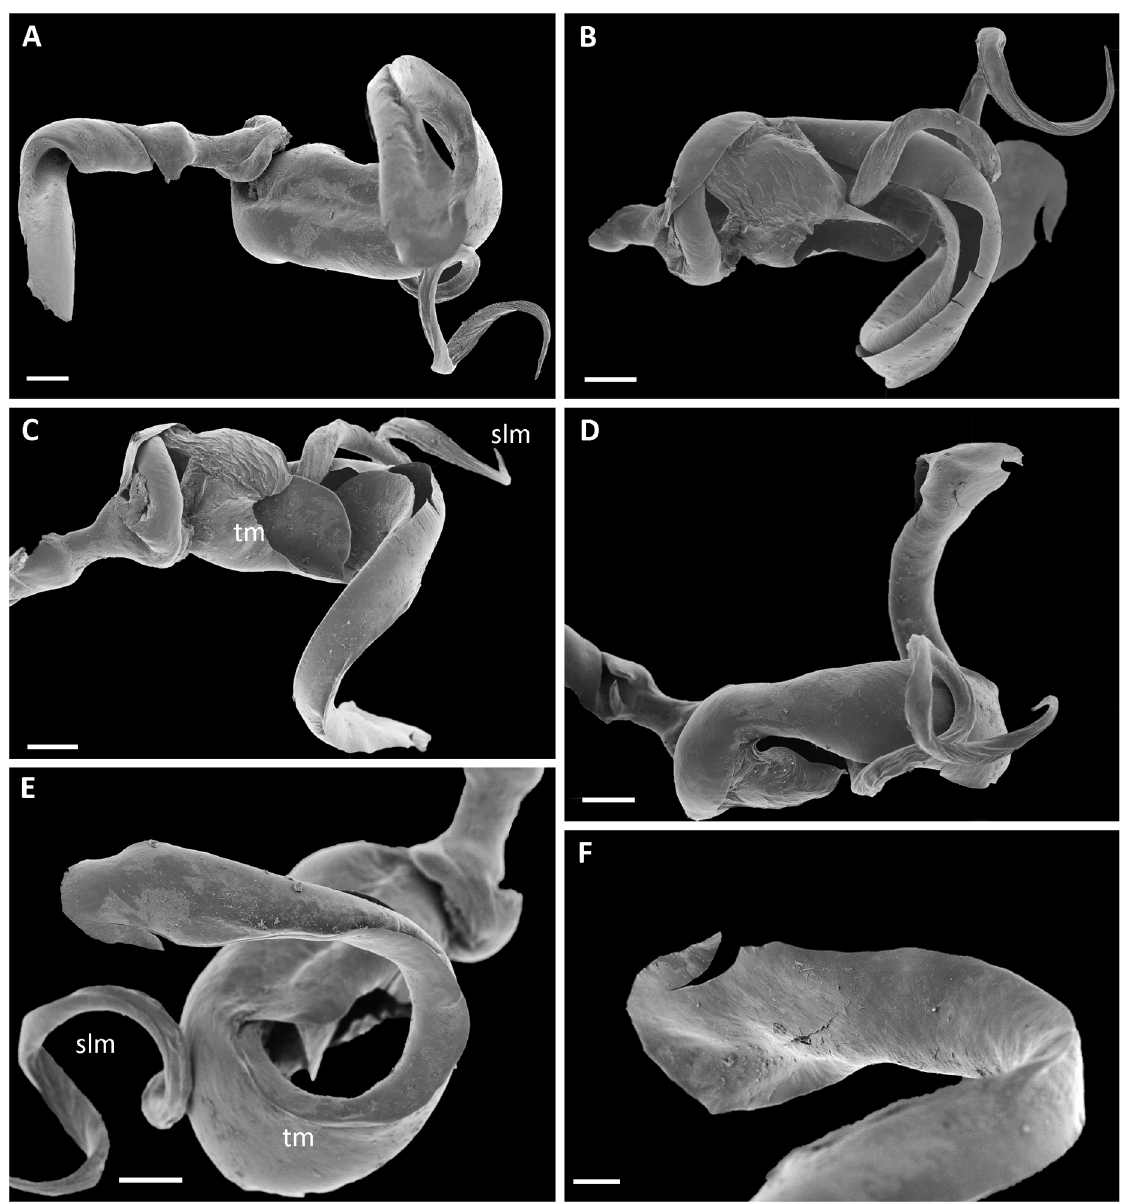
Fig. 15. Aquattuor nguruensis sp. nov., holotype, ♂ (VMNH110617), left gonopod telopodite. A . Anterior view. B . Posterior view. C . Distal (ventral) view. D . Basal (dorsal) view. E . Mesal view. F . Tip of telomere (damaged). Abbreviations: slm = solenomere; tm = telomere. Scale bars: A–E = 0.1 mm; F = 0.05